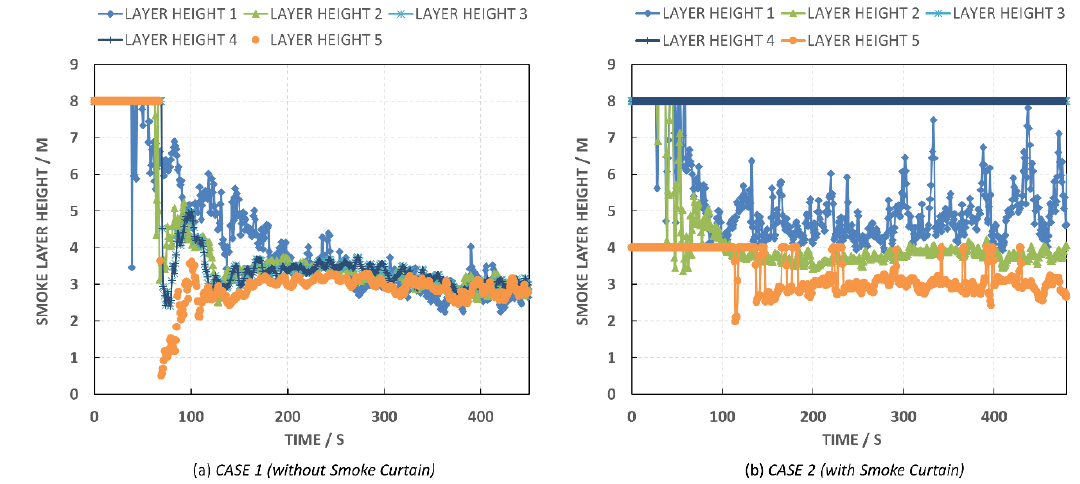
Figure 7. Smoke layer height prediction over time for ( a ) Case 1 and ( b ) Case 2 at locations T1–T5.